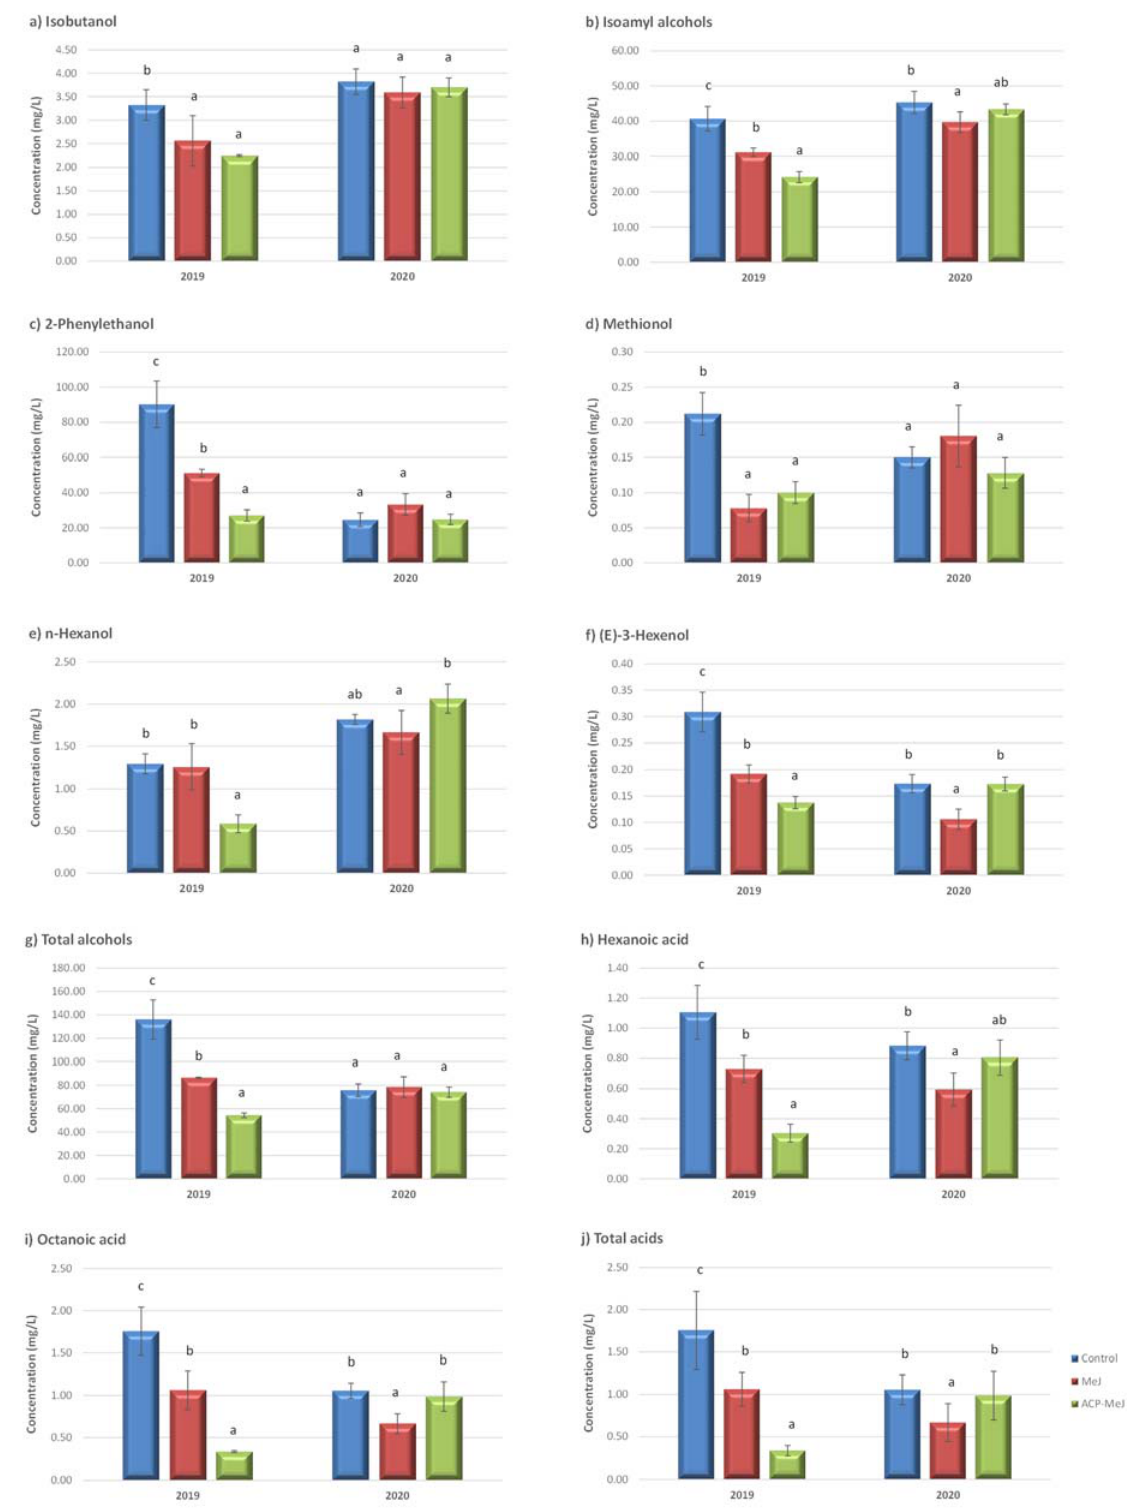
Figure 2. Alcohols and acids concentration (mg/L) in control wines and from methyl jasmonate (MeJ) and apatite doped with methyl jasmonate (ACP ‐ MeJ) treatments, in the two seasons (2019 and 2020). All parameters are listed with their standard deviation ( n = 3). For each season and compound, different letters indicate significant differences between the samples ( p ≤ 0.05).